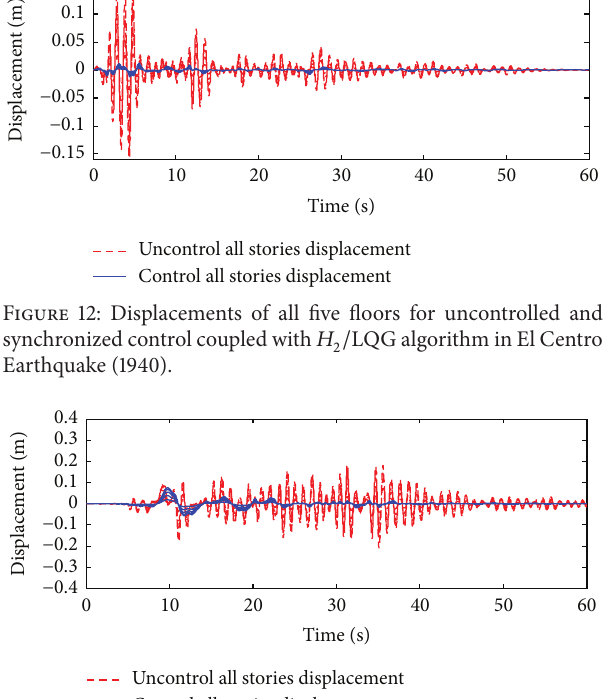
Figure 9: Time history graphs of displacement of fifth floor for uncontrolled and synchronized coupled with 𝐻 2 / LQG algorithm in Bam Earthquake.